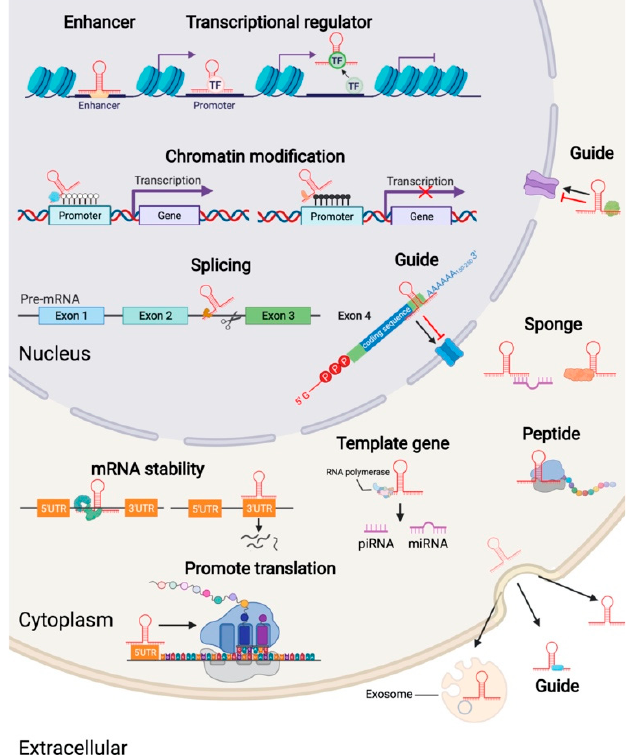
Figure 2. Biogenesis and function of long noncoding RNAs (lncRNAs). The lncRNA in the cell nucleus exerts its biological functions through the regulation of transcription, chromatin modification, variable splicing of mRNA, and changing the subcellular localization of mRNA. In the cytoplasm, lncRNA exerts biological functions by affecting the stability of mRNA, translation of mRNA, sponge-adsorbed protein, or miRNA. In addition, a small number of studies have shown that lncRNA can be transcribed to produce small peptides and can also function as precursor molecules of piRNA and miRNA. In addition, lncRNA can also be excreted outside the cell through exosomes, tricking proteins into transporting out of the cell or being excreted outside the cell alone to perform functions such as crosstalk.